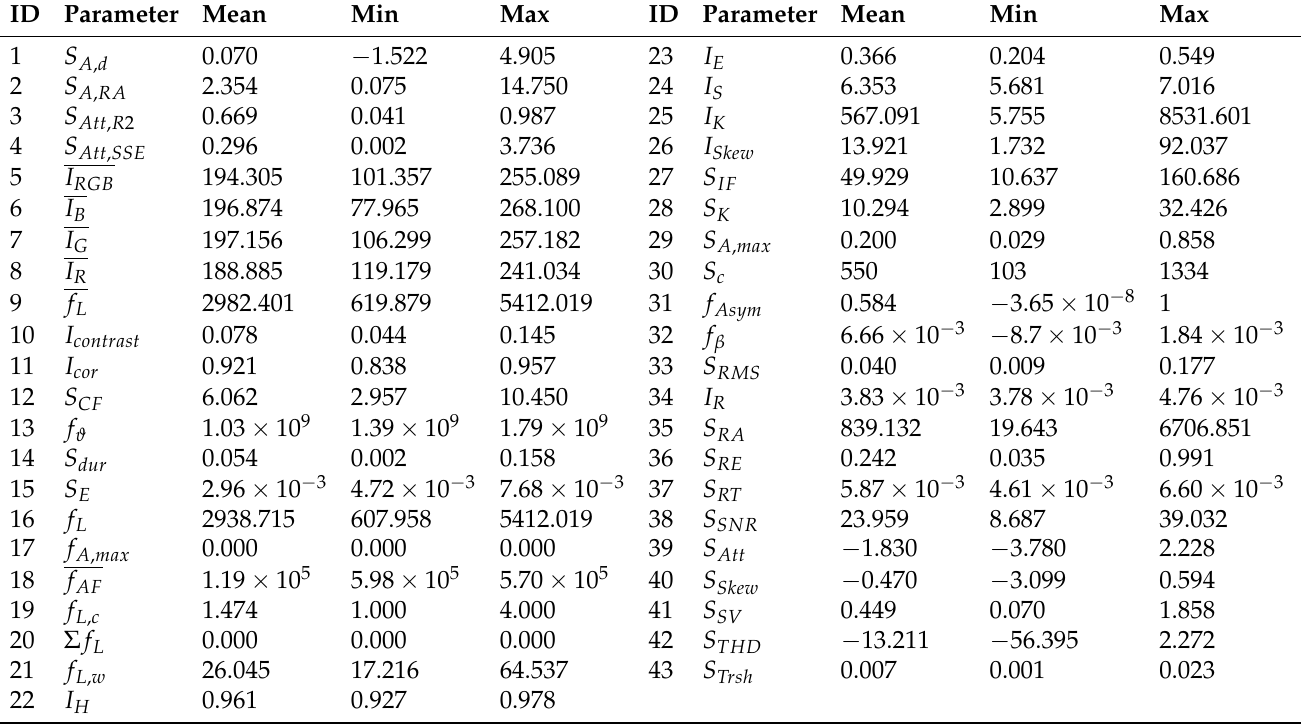
Table 6. Comparision of all extracted